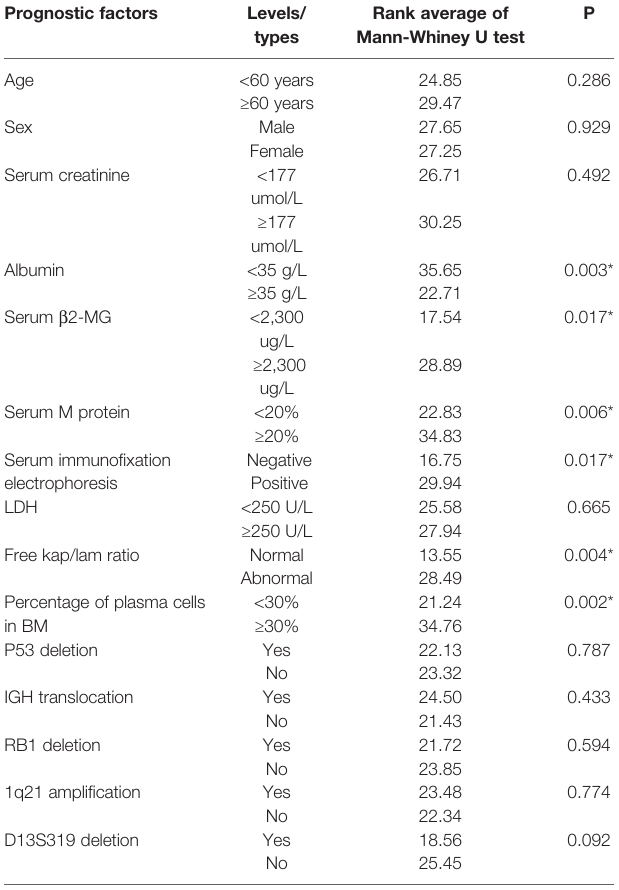
TABLE 3 | Comparison of BCMA in patients with different levels/types of each prognostic factor. Prognostic factors